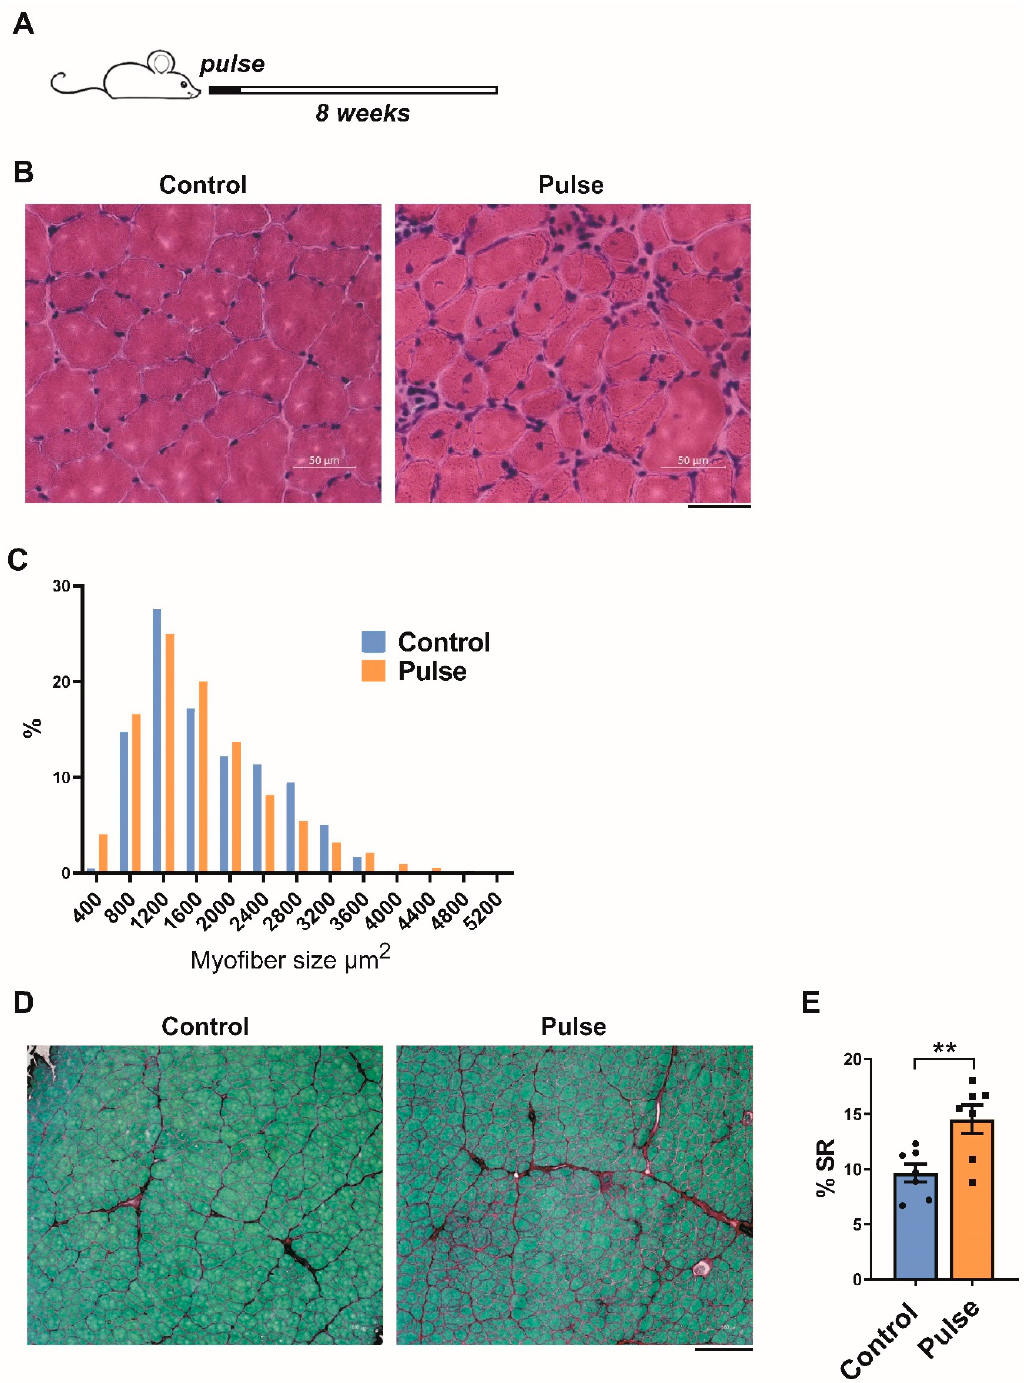
Figure 2. Fibrosis and myofiber size alterations 2 months after a 10 day pulse of DUX4. ( A ). Scheme of doxycycline pulse induction protocol in iDUX4pA;HSA mice. Mice received a pulse of doxycycline for 10 days. Muscles were analyzed histologically after 8 weeks of recovery, a time point at which they were 3 months of age. ( B ). Representative H&E image of TA muscle of iDUX4;HSA mice that were not doxycycline-induced (control) or pulse-induced mice (pulse). Scale bar 50 μ m. ( C ). Myofiber size distribution in TA of control and pulse-induced mice. X-axis represents myofiber size distribution bins. ( D ). Representative images of Sirius Red/Fast Green staining of quadriceps from WT and iDUX4pA;HSA mice 8 weeks after a 10 day pulse of DUX4. Scale bar 100 µ m. ( E ). Quantification of deposition of fibrous tissue in the muscle presented in ( C ). Data represent mean ± SEM; ** p < 0.01 by t -test, n =